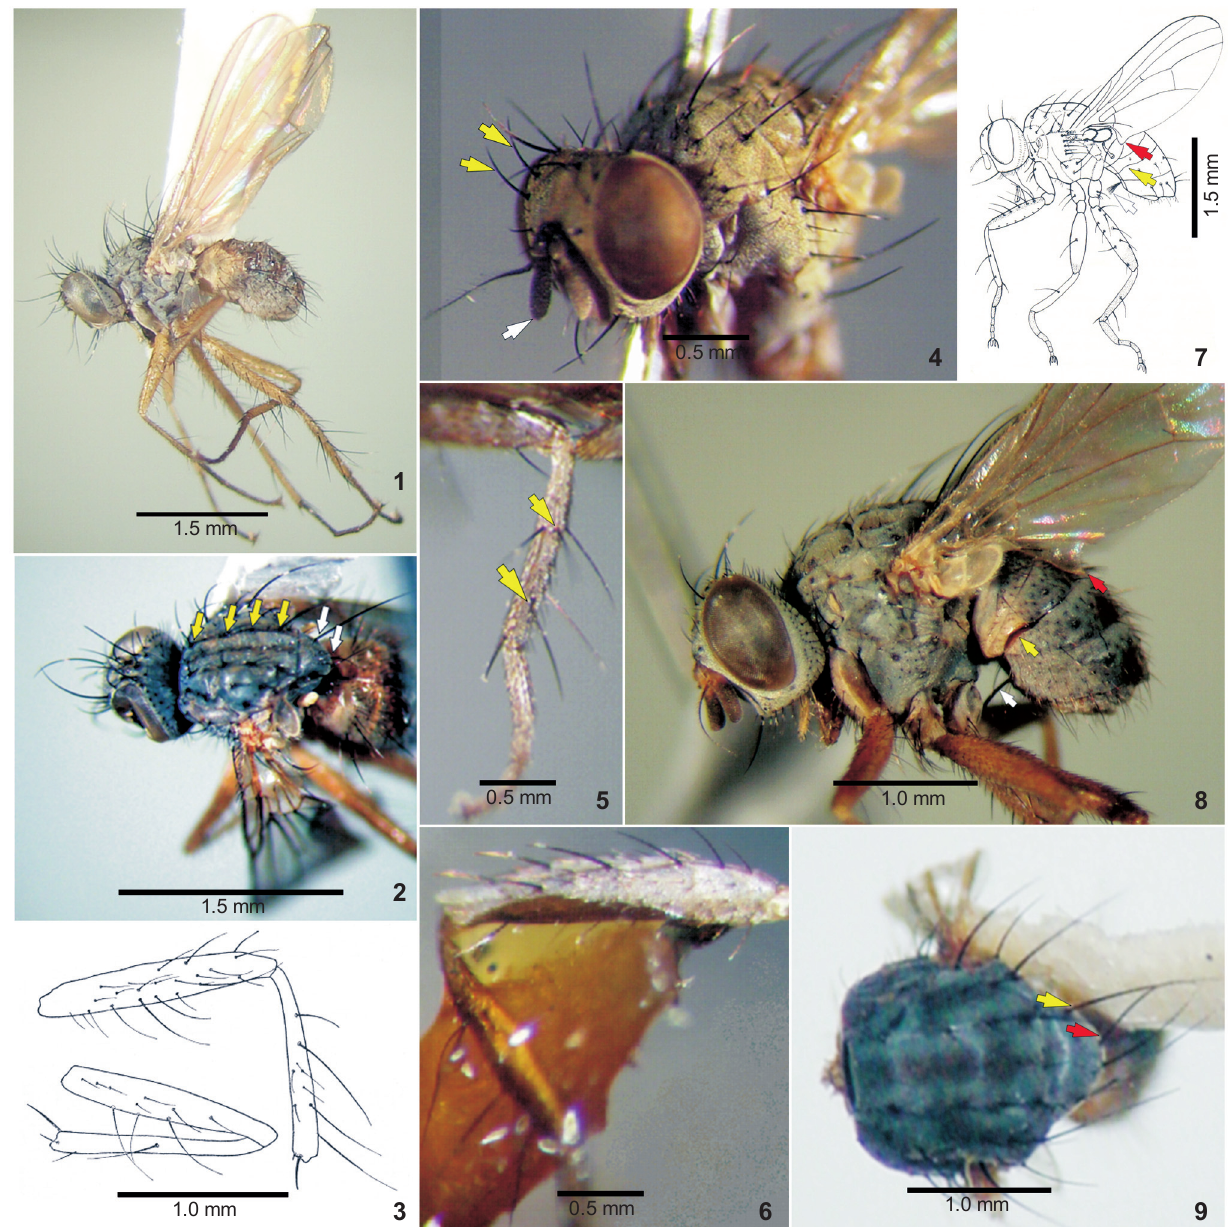
Figures 1-9. (1-3) Pilispina pilitibia : (1) habitus; (2) DC setae (yellow arrows) and scutellar setae (white arrows); (3) mid (lower) and hind (upper) legs in anterior view redrawed from A LBUQUERQUE (1954). (4-6) Pilispina xanthogaster : (4) habitus, second and the third frontal pairs of setae (yellow arrows), pollinosity on head and mesonotum and apex of flagellum rounded (white arrows); (5) hind tibia in anterior view and AD setae on middle third of posterior tibia (yellow arrows), (see Tab. I); (6) colour of the hind femur in anterior view. (7-8) Neodexiopsis flavipalpis : (7) modification with a lobe of the male wing (red arrow), third and fourth tergites modified (yellow arrow) and presence of a group of strong, comb-like setae on sternite 4 (white arrow), redrawed from C OURI & A LBUQUERQUE (1979); (8) same as figure 7. (9) Neodexiopsis medinai : apical scutelar setae (red arrow) a little shorter related to the sub- basal ones (yellow ZOOLOGIA 27 (2): 258–262, April, 2010